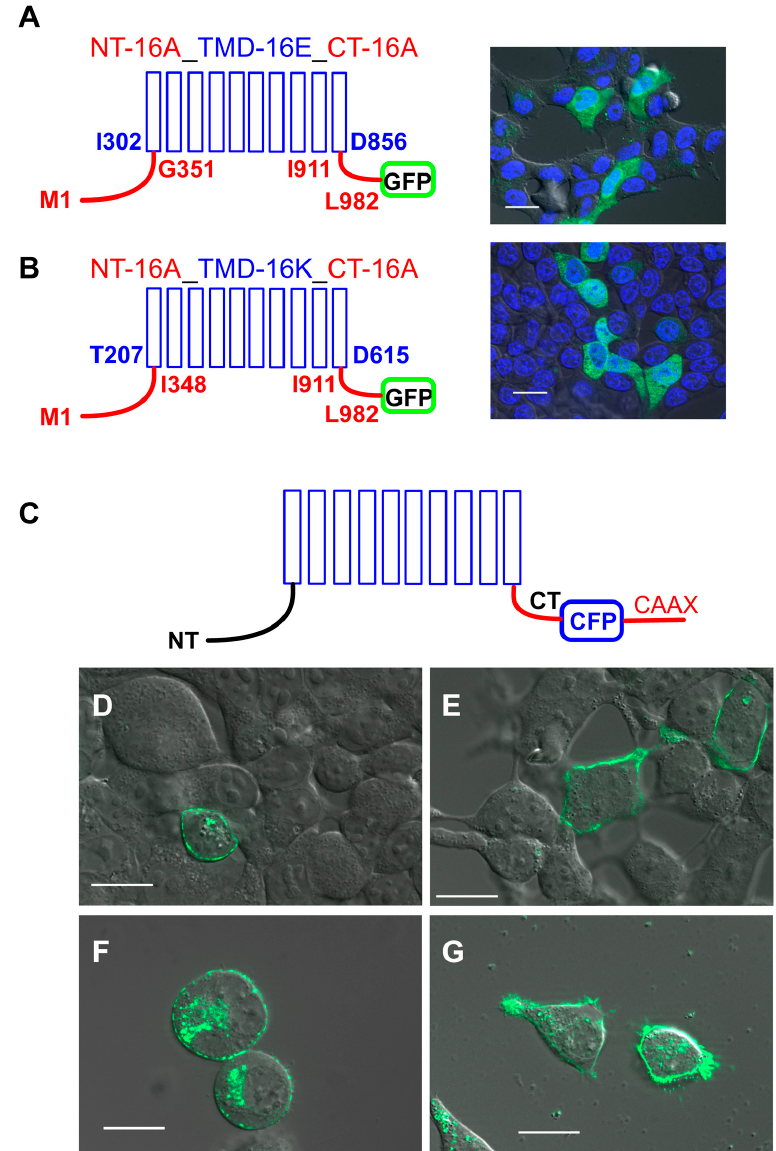
Figure 2. Expression of TMEM16 proteins. Chimeras of TMEM16A/TMEM16E and TMEM16A/TMEM16K were located in intracellular compartments (A,B), while TMEM16 paralogs were targeted by the CAAX motif to the plasma membrane (C-G). N-terminus (NT, amino acid (aa) M1-G351 or M1-I348) and C-terminus (CT, aa I911-L982) of TMEM16A (red lines) were cloned to the transmembrane domains (blue columns) of ( A ) TMEM16E (aa I302-D856) and ( B ) TMEM16K (aa T207-D615). In living HEK293 cells, localization of the chimeras was visualized by C-terminal-tagged GFP proteins (green). ( C ) Cyan fluorescent protein (CFP) (blue) and the CAAX motif (red) were cloned to the C-terminus (CT) of TMEM16 proteins. In living cells ( D ) TMEM16E-CFP-CAAX, ( E ) TMEM16H-CFP-CAAX, ( F ) TMEM16J-CFP-CAAX and ( G ) TMEM16K-CFP-CAAX were located at the plasma membrane. N-terminus (NT), Bar 20 µm.